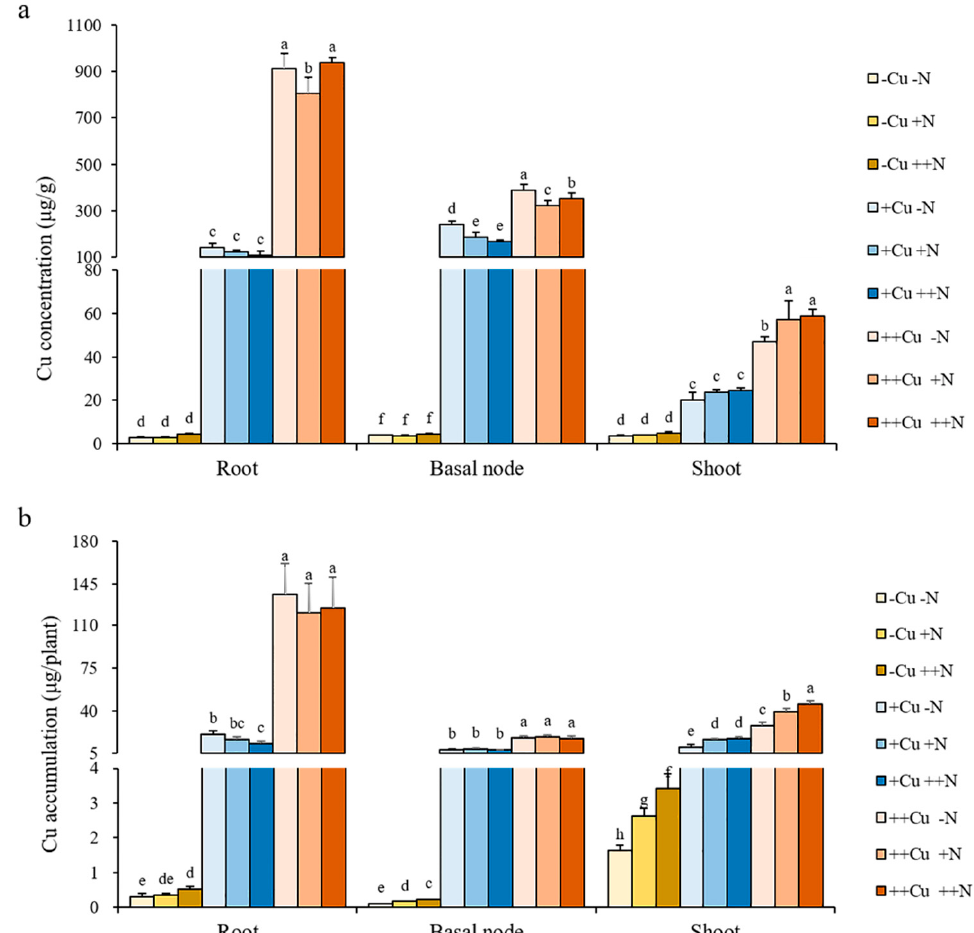
Figure 4. Cu concentration ( a ) and accumulation ( b ) in the root, basal node, and shoot of rice plant grown in solutions with different combinations of Cu (-Cu, 0 μ M; +Cu, 0.15 μ M; ++Cu, 1.5 μ M) and N (-N, 0.288 mM; +N, 2.88 mM; ++N, 14.4 mM) supply for three weeks. The Cu accumulation was calculated as Cu concentration × dry weight. Data are means ±SD of three biological replicates. Different letters indicate significant difference at p < 0.05 by Tukey’s test.